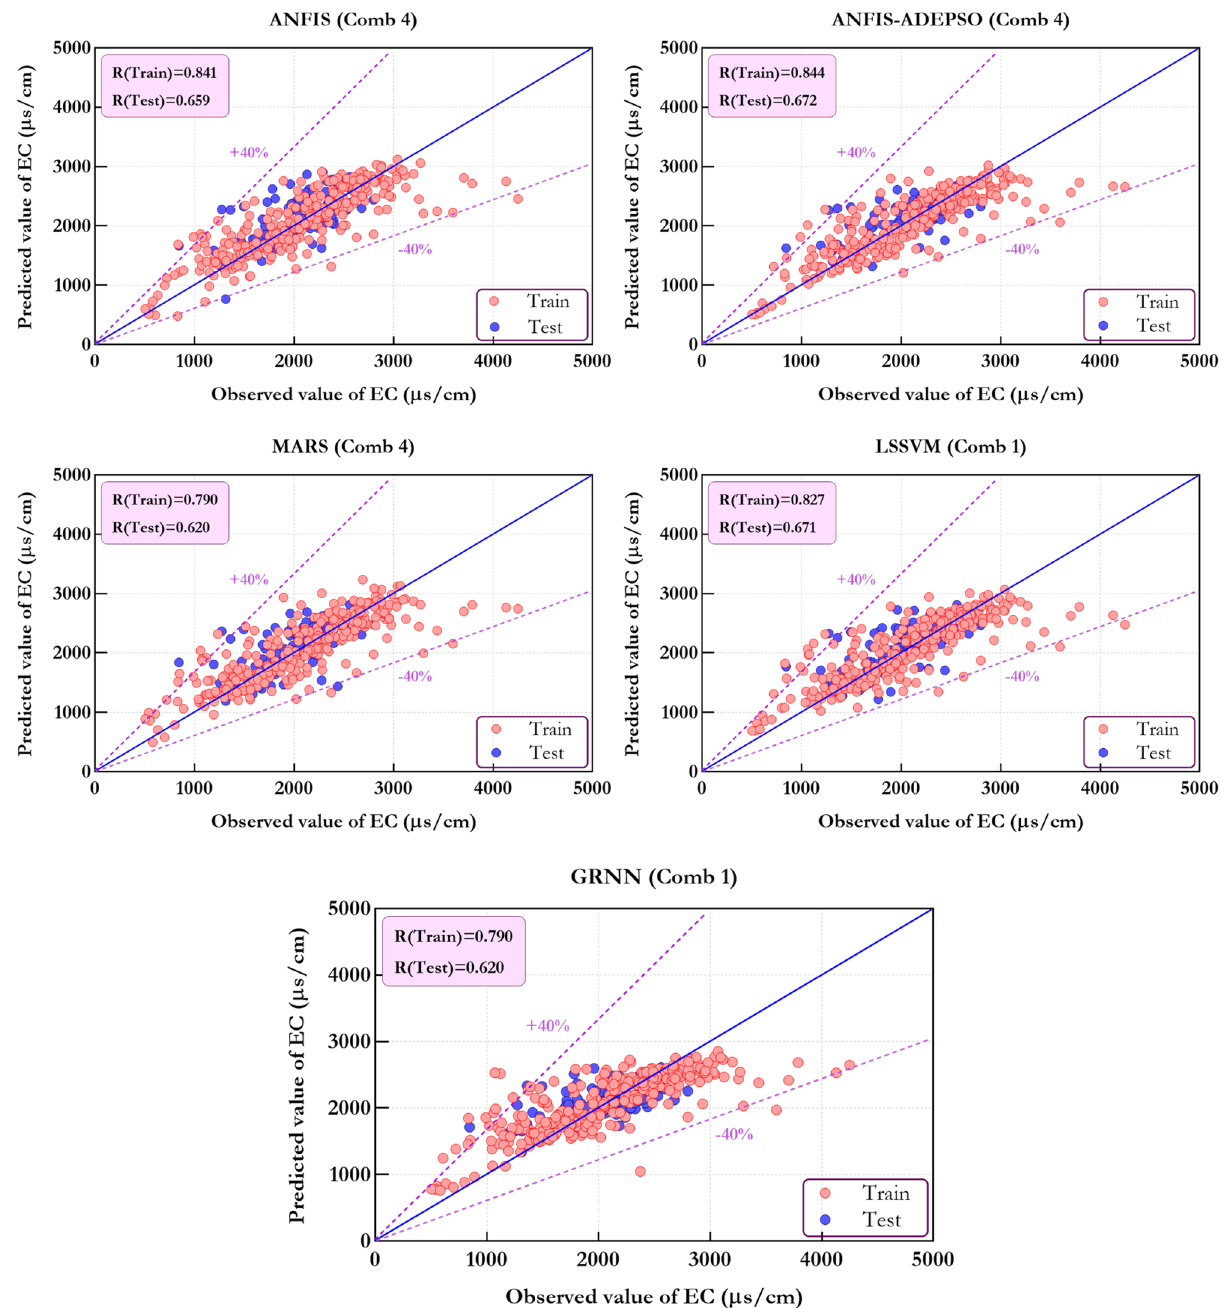
Figure 10. Compare estimated and measured values of EC utilizing the standalone ML models in the form of scatter